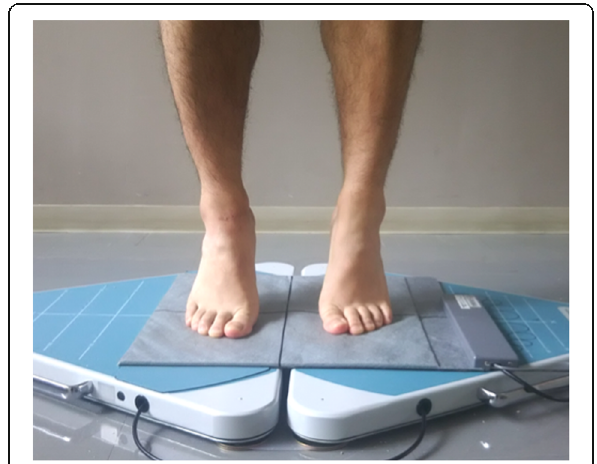
Fig. 4 Measurement of the plantar pressure distribution in the heel- raise position. Participants were kept the maximum heel-raise position for 10